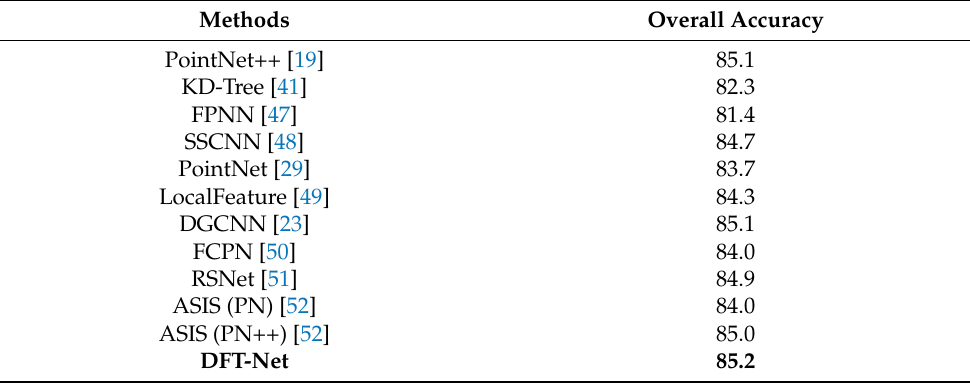
Table 3. Overall Accuracy of Part Segmentation Results on ShapNet Part dataset.